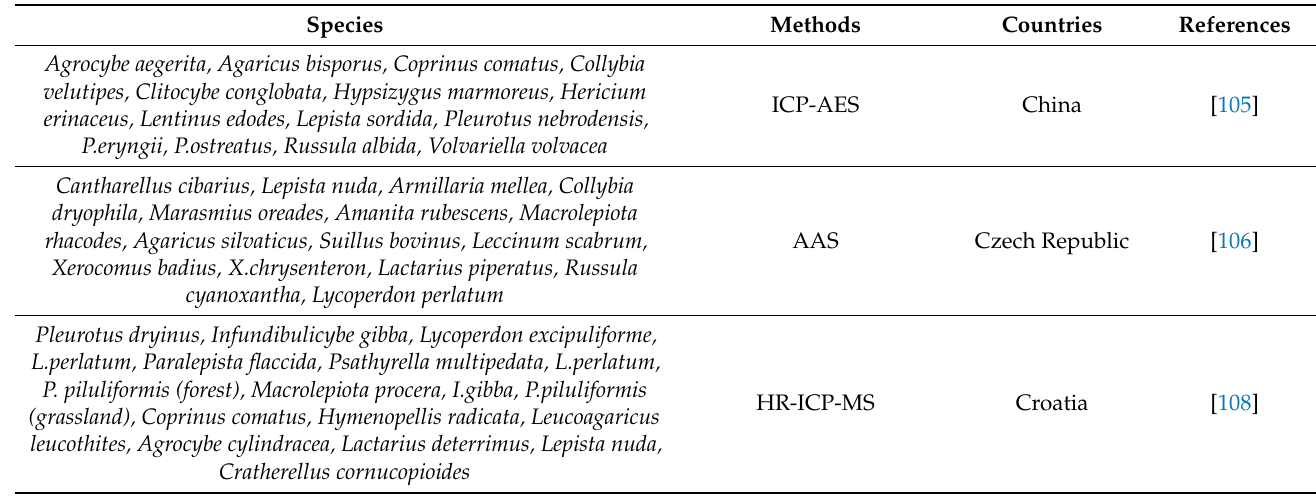
Table 8. Species, methods for determination of cadmium, and countries in the